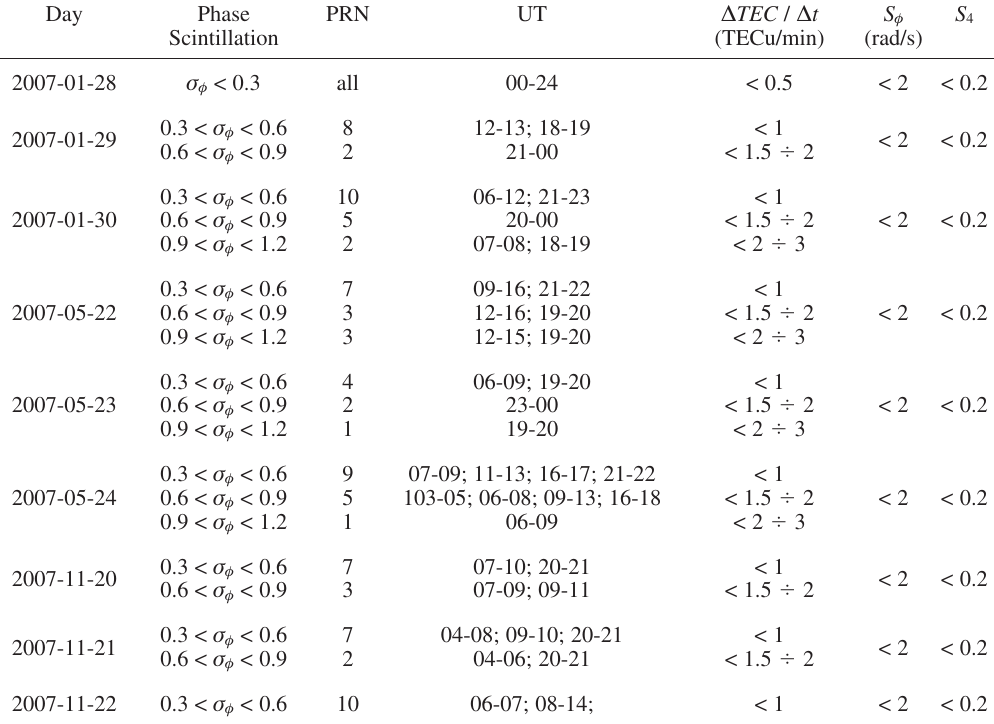
Table II. All the events analysed in 2007. The σ φ values are divided into intervals, according to the phase scin- tillation levels that occurred on a particular day. The PRN column shows the number of satellites which meas- ured a σ φ in a given range and during a given UT period (UT column) for that particular day. Corresponding val- ues for TEC fluctuations, S φ and S 4 are given in separate